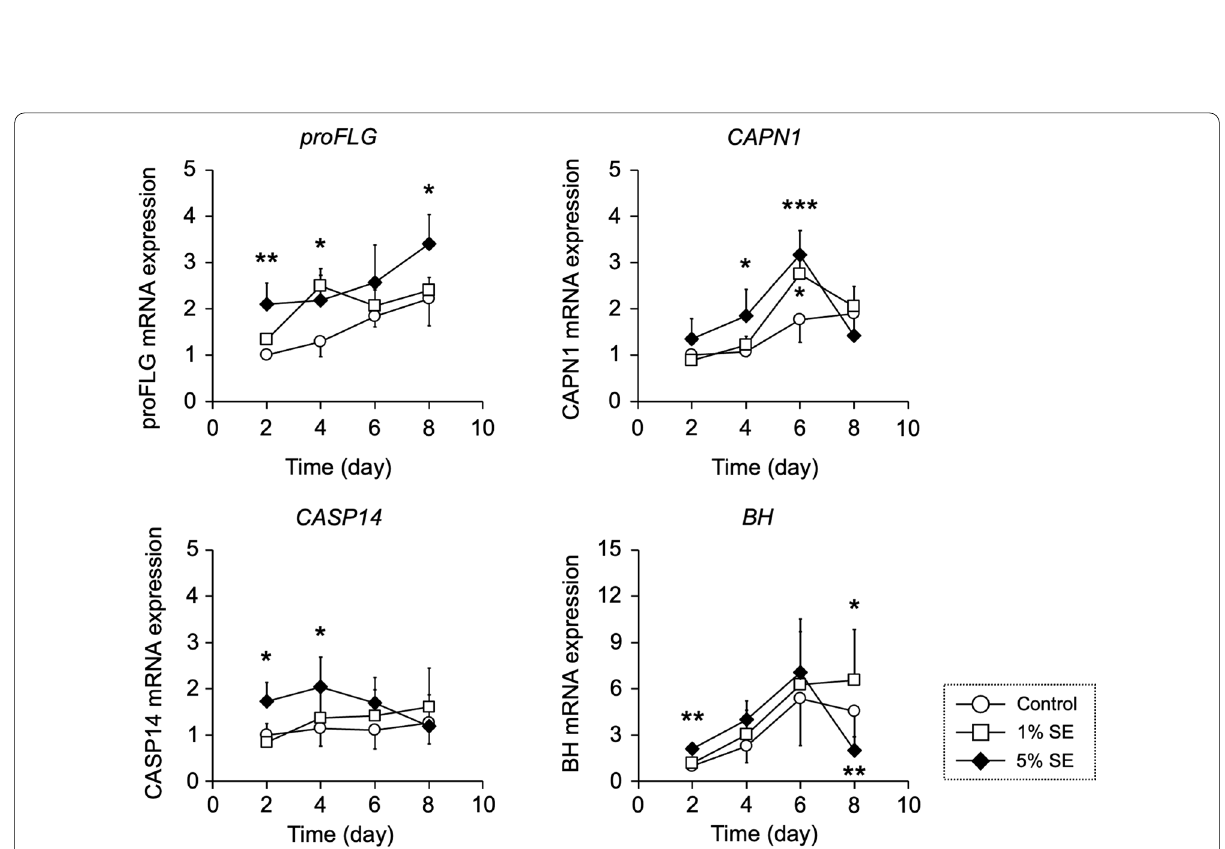
Fig. 3 Effects of natural moisturizing factor-related gene expression in three-dimensional cultured human epidermis. Three-dimensional cultured human epidermis was treated with SE for 2–8 days. CAPN1 , CASP14 , and BH mRNA expression was assessed by quantitative real-time PCR. Data are expressed as mean S.D. of four independent experiments. * p < 0.05, ** p < 0.01, and *** p < 0.001 (compared with control group at the same time ± point). Statistical significance was evaluated using Dunnett’s